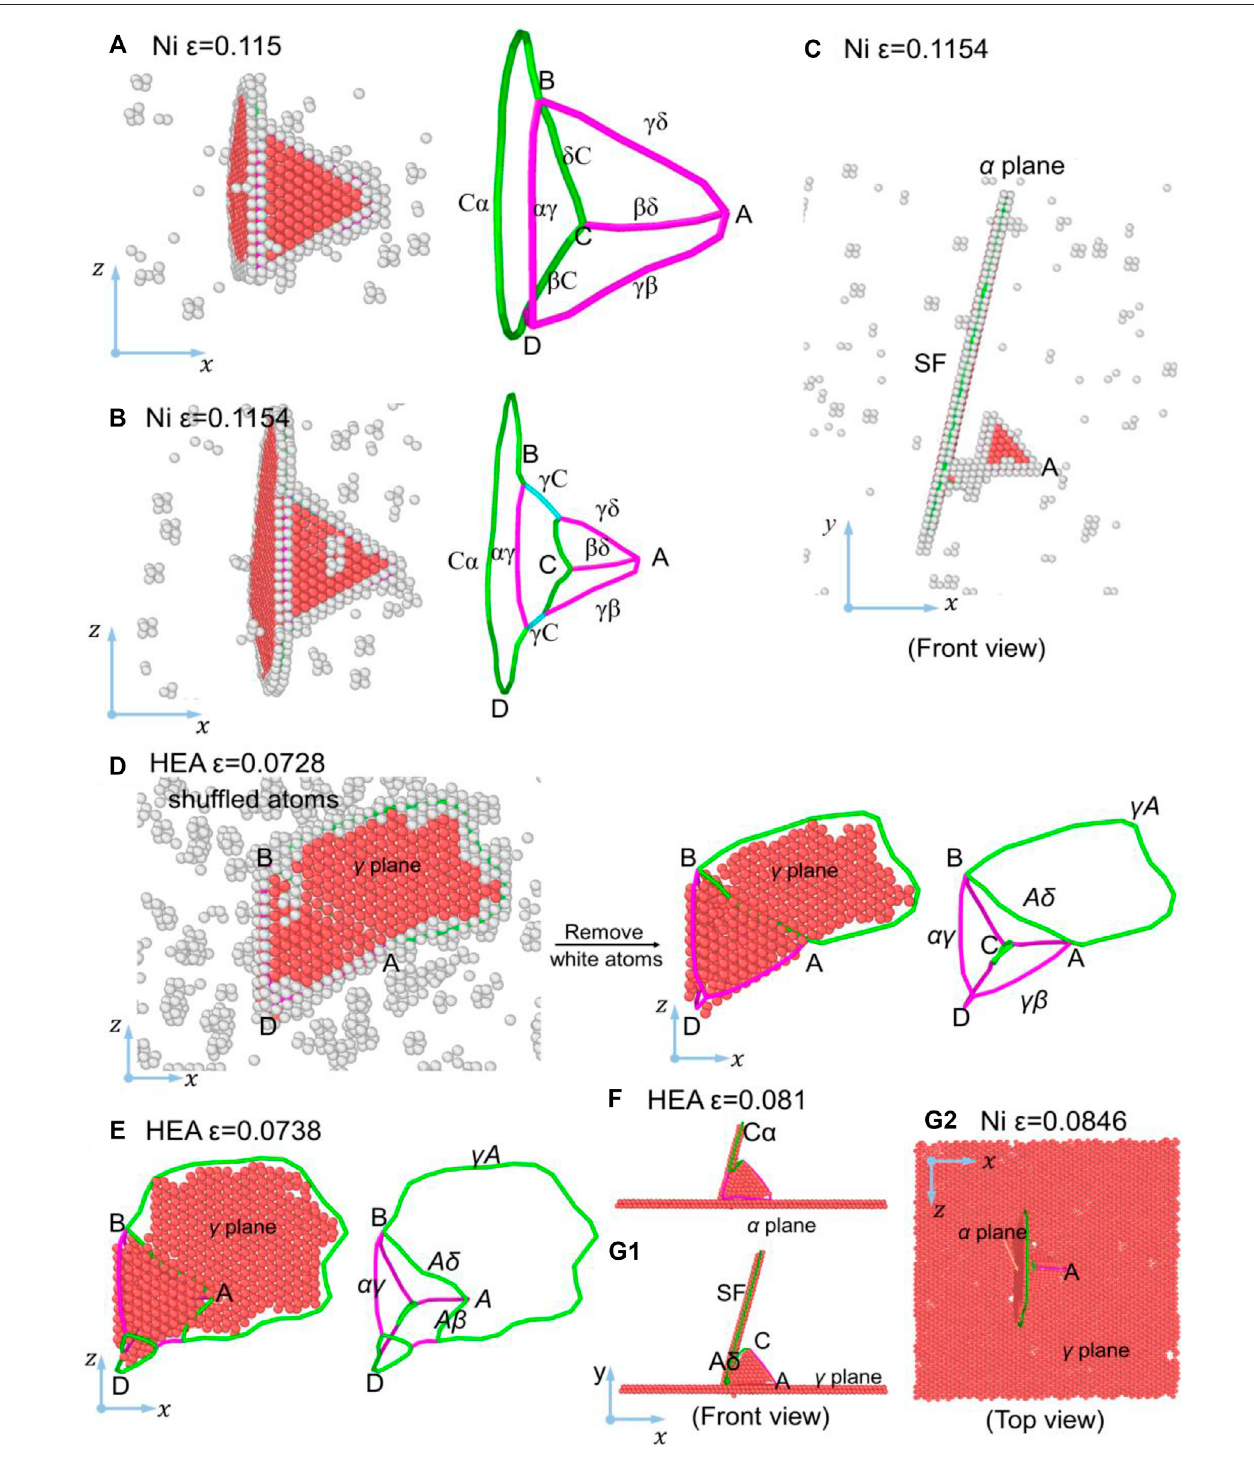
FIGURE 4 | Atomic structure of SFT in Ni and CoCrFeNiMn samples sheared along ( 111 )[ 112 ] at different shear strains. (A – C) Ni; (D – G) CoCrFeNiMn HEA.